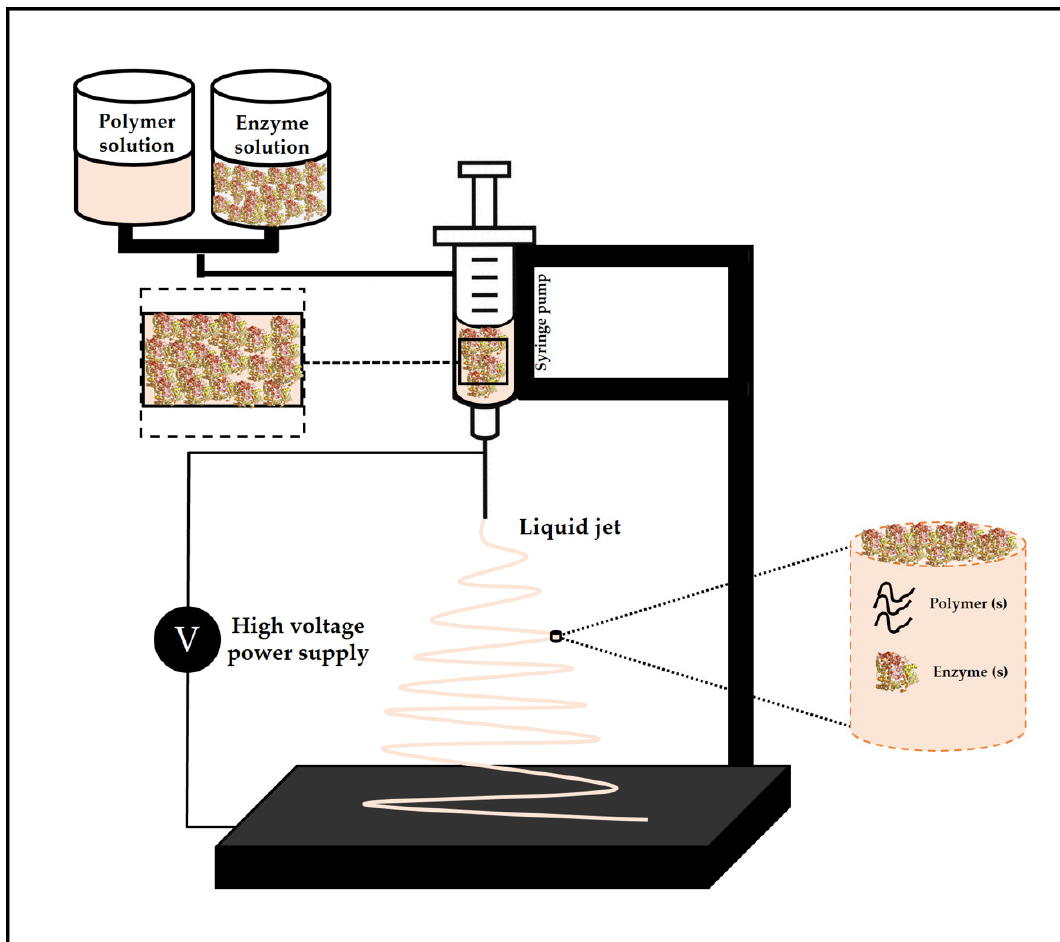
Figure 3. Basic diagram of the electrospinning process.